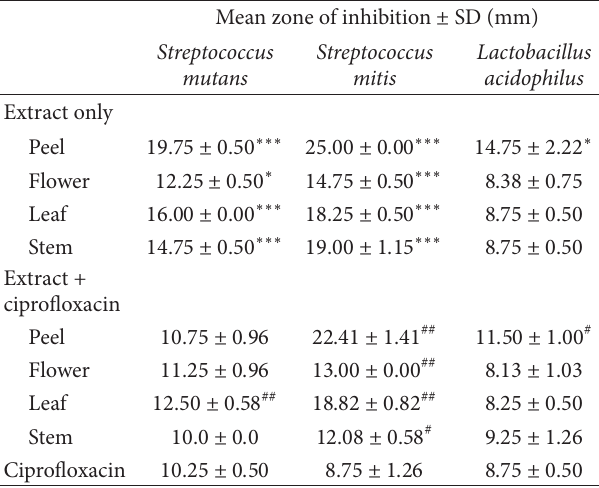
Table 3: Zone of inhibition or minimum growth (mm) by various parts of Punica granatum on S. mutans, S. mitis , and L. acidophilus .